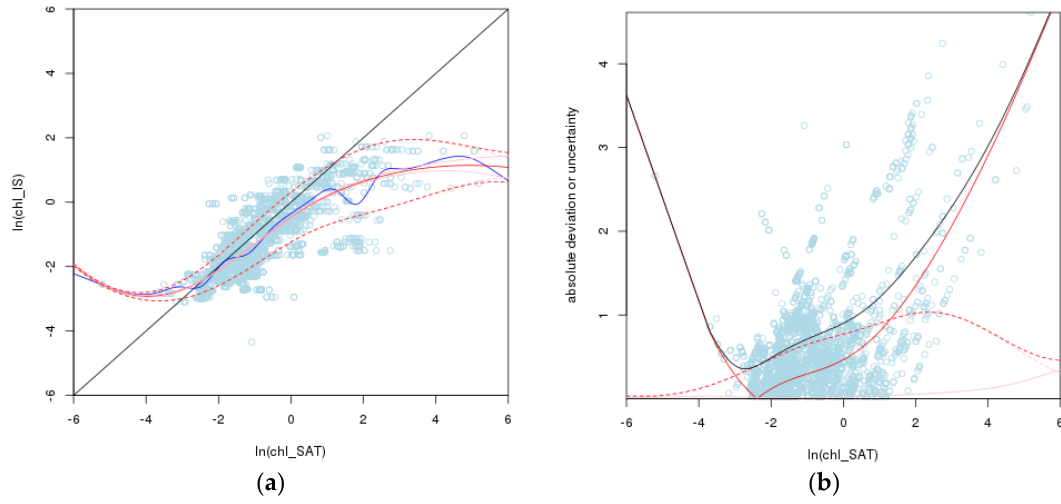
Figure 2. A simple uncertainty model in which ln(chl SAT ) is the only explanatory variable. ( a ) The points are ln(chl IS ) plotted against ln(chl SAT ), and the black line is the 1:1 line. The blue line shows the best fitting pb(ln(chl SAT )) mean model, and the solid red line shows the best fitting ps(ln(chl SAT )) mean model. The remaining lines are offset above and below the latter. The solid pink line is offset by the standard error, the dashed pink line (almost overlapping with the dashed red line) by the best fitting ps(ln(chl SAT )) standard deviation model, and the dashed red line by the square root of the sum of squares of standard error and standard deviation. ( b ) Contributions to absolute uncertainty using the ps(ln(chl SAT )) mean model. The points are the absolute difference between ln(chl SAT ) and ln(chl IS ); the solid red line is the absolute bias; the solid pink line is the standard error; the dashed pink line is the standard deviation; the dashed red line is the square root of the sum of squares of standard error and standard deviation; and the solid black line is the square root of the sum of squares of bias, standard error, and standard deviation.